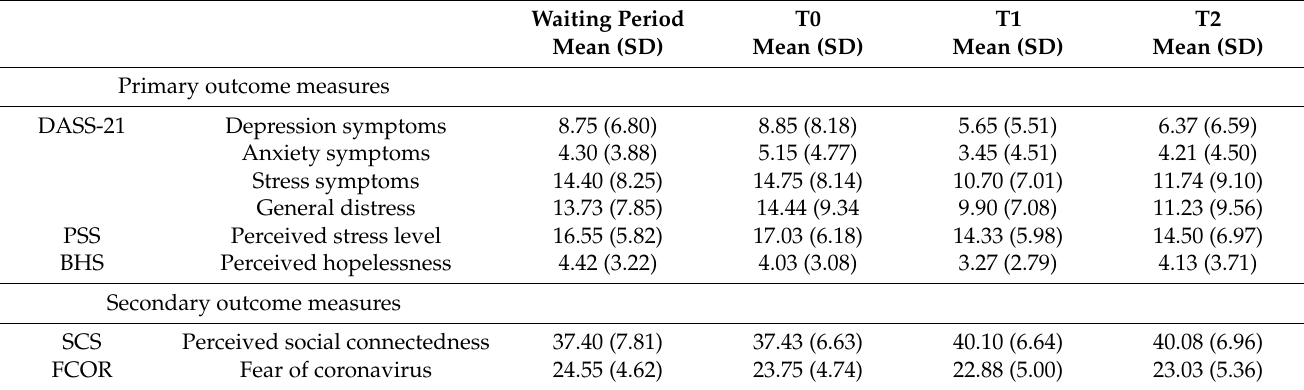
Table 2. Descriptive statistics for the primary and outcome measure across the different time points by time points (7 days before the start of the intervention—Waiting Period, before the start of the intervention, Day 0—T0; end of the intervention, Day 7—T1; 2-week follow-up, Day 21—T2). Data are provided in means and standard deviation (SD). Depression Anxiety Stress Scale Subscale Depression-21: DASS_21; Perceived Stress Scale: PSS; Beck Hopelessness Scale: BHS; Social Connectedness Scale: SCS; Fear of Coronavirus outcome: